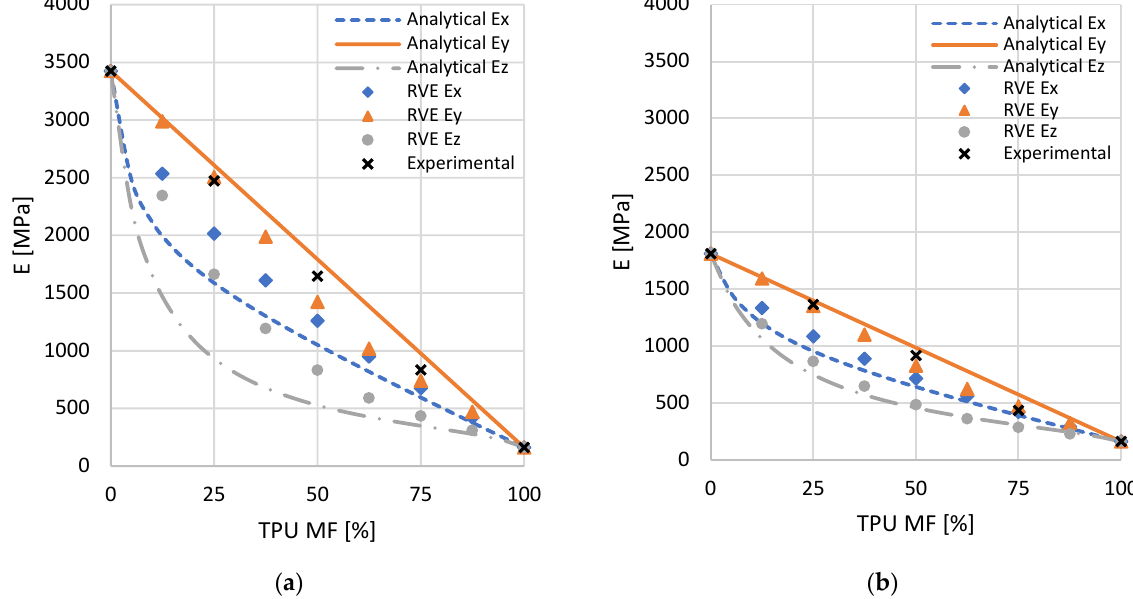
Figure 17. Comparison of the elastic moduli of analytical model, RVE, and tensile tests for the pairs: ( a ) PLA-TPU and ( b ) PLA-TPU.